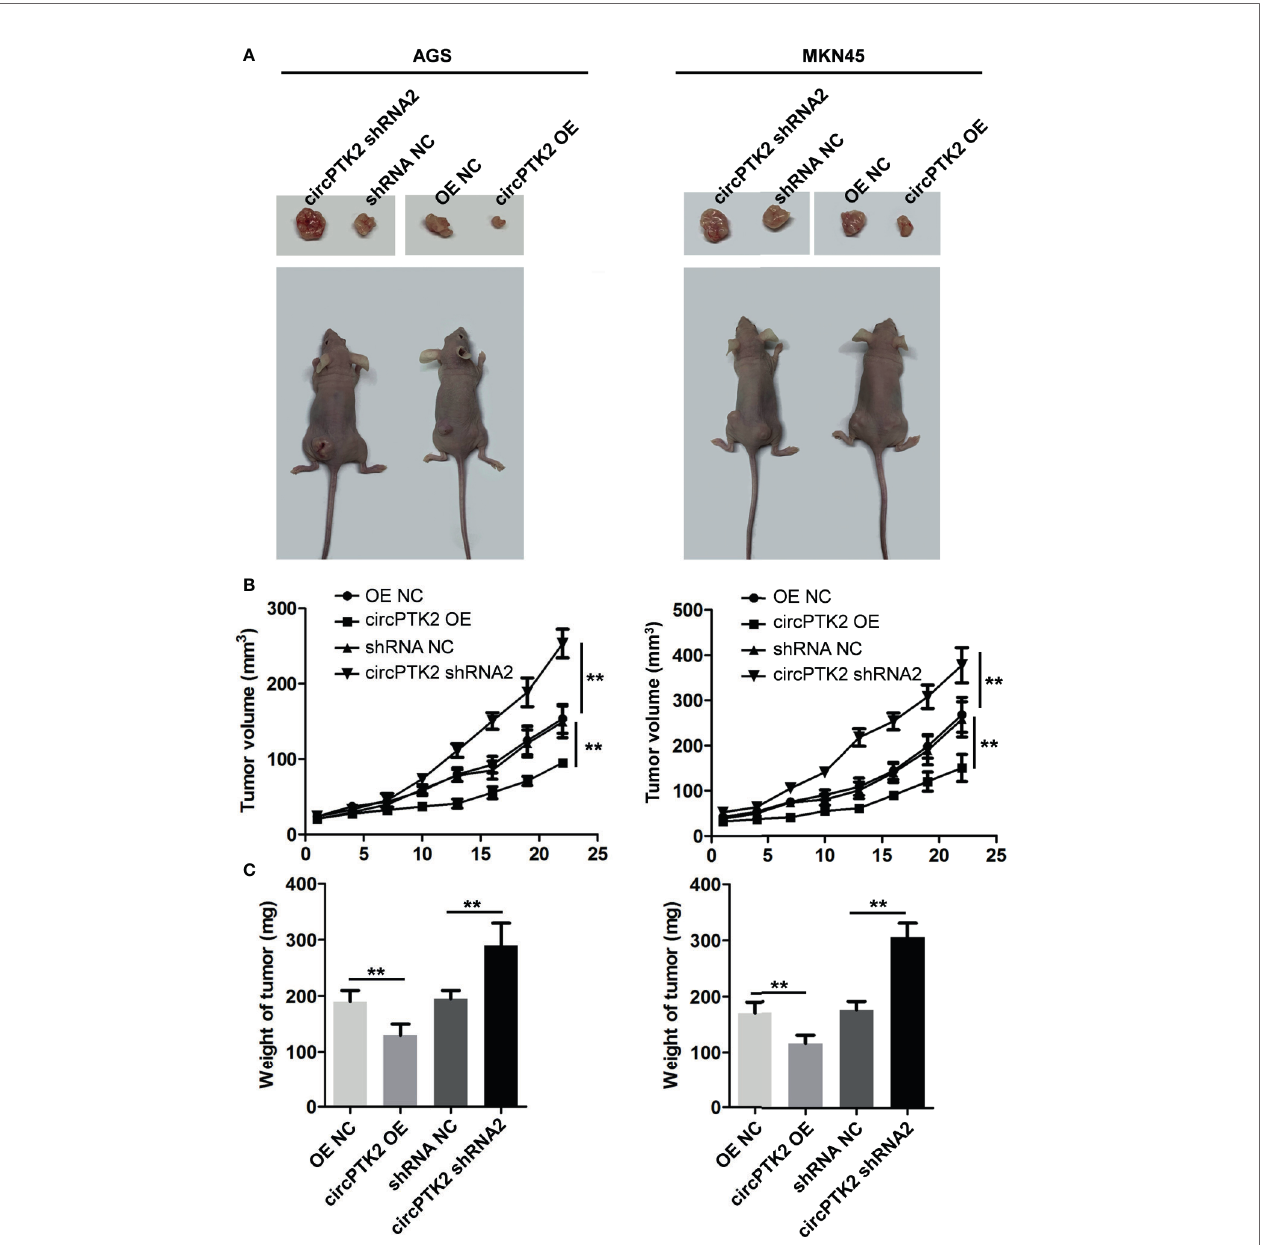
FIGURE 4 | Overexpression of circPTK2 inhibits gastric cancer cell growth in vivo . (A – C) Tumor volume and tumor weight of xenograft tumors. ** p < 0.01. The signi fi cance between the four groups was analyzed by one-way